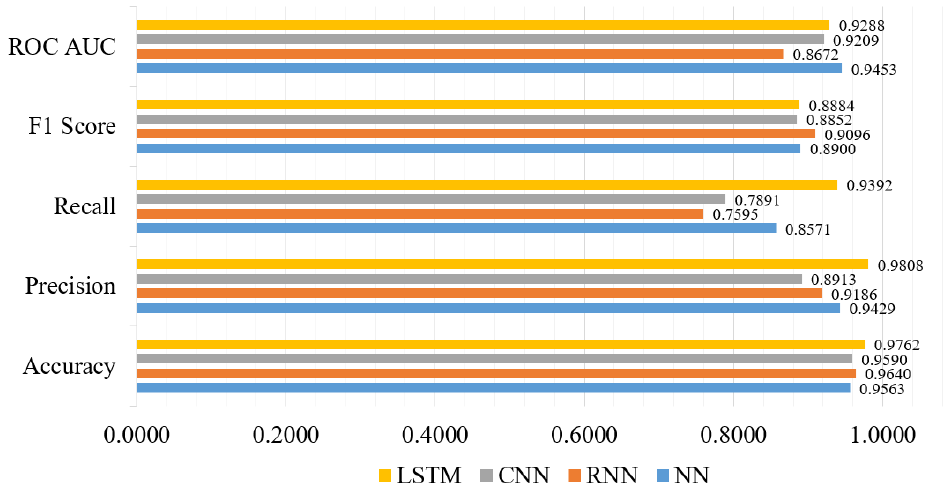
Figure 10. DL models’ performance metrics visualization.